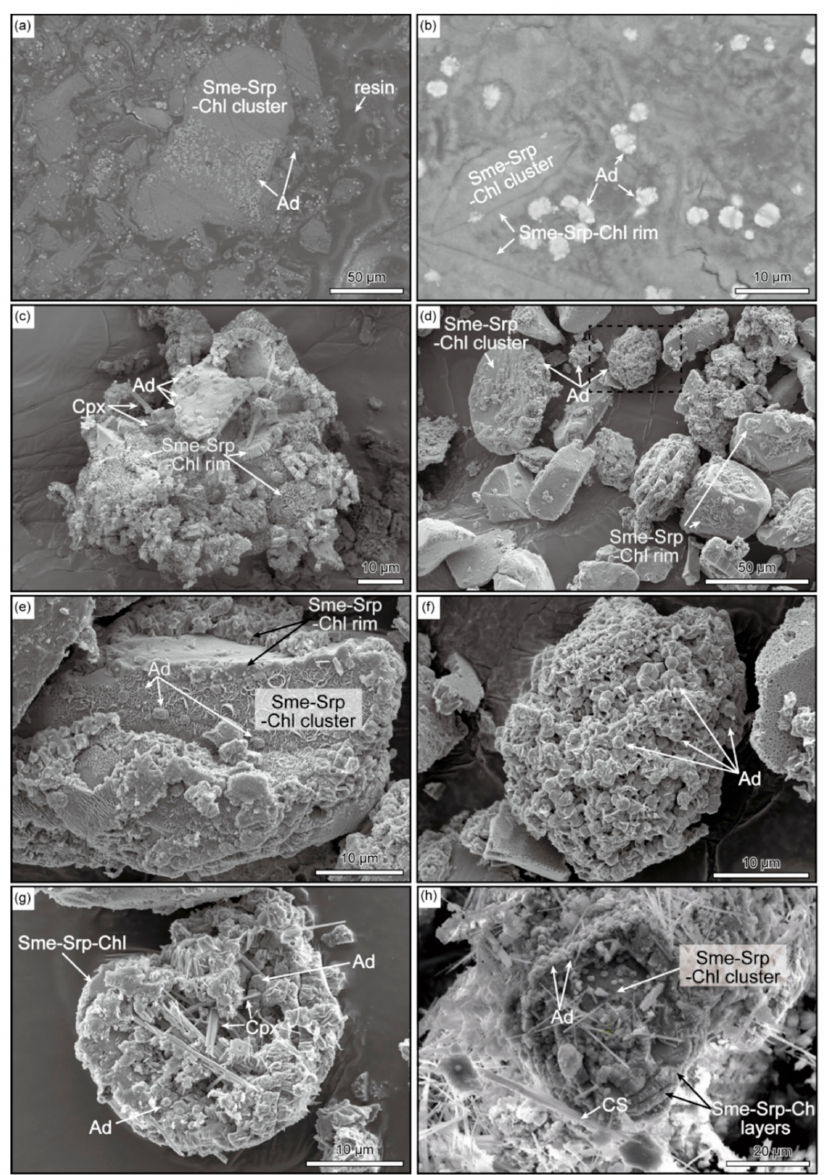
Figure 5. Representative SEM images of alteration products after experiment N250 (250 ◦ C, 4877 h). ( a , b ) Polished sample mounted on epoxy resin showing 10–50 µ m-size clusters comprising phyl- losilicates (smectite, serpentine, and chlorite: Sme-Srp-Chl) in the core with overgrowth rims of phyllosilicates and bright spherical andradite. The dark portion of these panels is epoxy resin. ( c ) Ag- gregate of crushed samples showing various morphologies of individual grains. ( d – g ) SEM images of the unsuspended fraction separated from bulk products by sonication with water and ethanol ( d ) Clusters of phyllosilicates that are partially covered by phyllosilicates with frost column textures and/or andradite. ( e ) Cluster of phyllosilicates. The core of the cluster comprises plates/flakes that develops an edge-to-face pattern and/or a rosette-like pattern, whereas the rim shows frost column texture. ( f ) Enlarged view of a dashed black frame in ( d ) showing botryoidally aggregated andra- dite spheres overgrown on the surface of phyllosilicate cluster. ( g ) Spherical aggregate comprising clinopyroxene needles, andradite spheres, and phyllosilicates. ( h ) Cross sectional view of phyllosil- icate cluster covered by phyllosilicate layers. Spherical andradite crystals occur with needle-like calcium silicate (CS) at the surface of the upper most layer of phyllosilicates. Abbreviations are the same as in Table